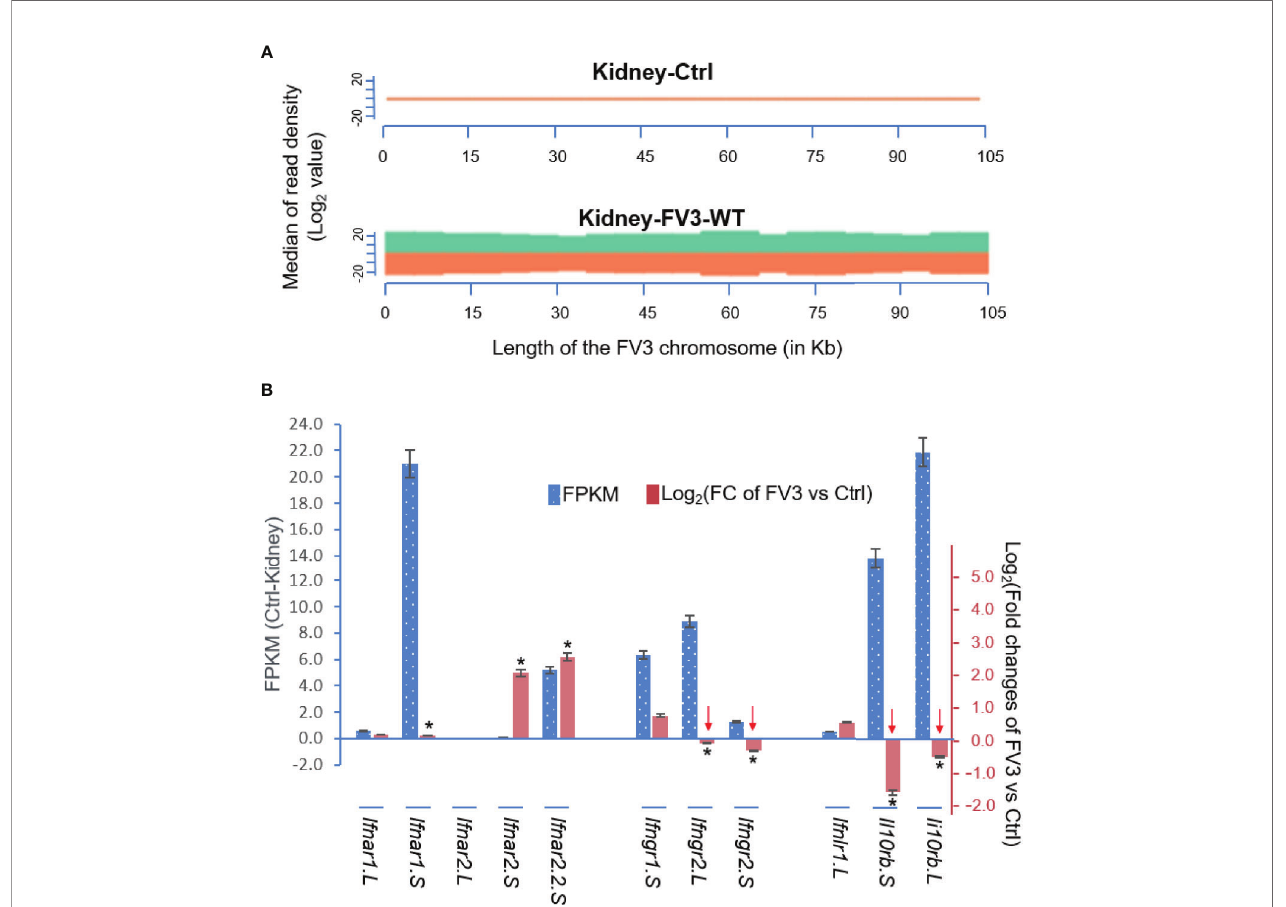
FIGURE 7 | Transcriptomic analysis of the viral genome and X. laevis mRNA encoding interferon receptor subunits in the control (Ctrl) and FV3-infected kidney. (A) The virus-targeted transcriptome analysis shown as a distribution plot of mapped reads in FV3 genome (GenBank Accession No. NC_005946.1). The X-axis shows the length of the genome (in Mb, 0.105 Mb of FV3), and the Y-axis indicates the log 2 of the median of read density. Green and red indicate the positive and negative strands, respectively. Note, no FV3 transcript read was obtained from the control (Ctrl) mock-infected kidney, and the full coverages of both positive and negative reads on the FV3 genome in the infected kidney. (B) Family-wide transcriptomic analysis of X. laevis mRNA encoding interferon receptor subunits for type I (ifnar1/2), II (ifngr1/2), and III (ifnlr1/il10rb) IFNs to show the differential expression of these IFN receptor genes in the kidney (Blue bars against the left Axis for FPKM, Fragments Per Kilobase of transcript per Million mapped reads) and regulated expression in FV3-infected kidney (Orange bars against the right Axis for Log2 fold changes). Note the signi fi cant reduction of the beta-subunits of type II and type III IFN receptors (indicated by red arrows), which may putatively result from a higher enrichment of the intergenic miRNA species as shown in Table 1 . *p (FDR) < 0.05 relative to the control, n =